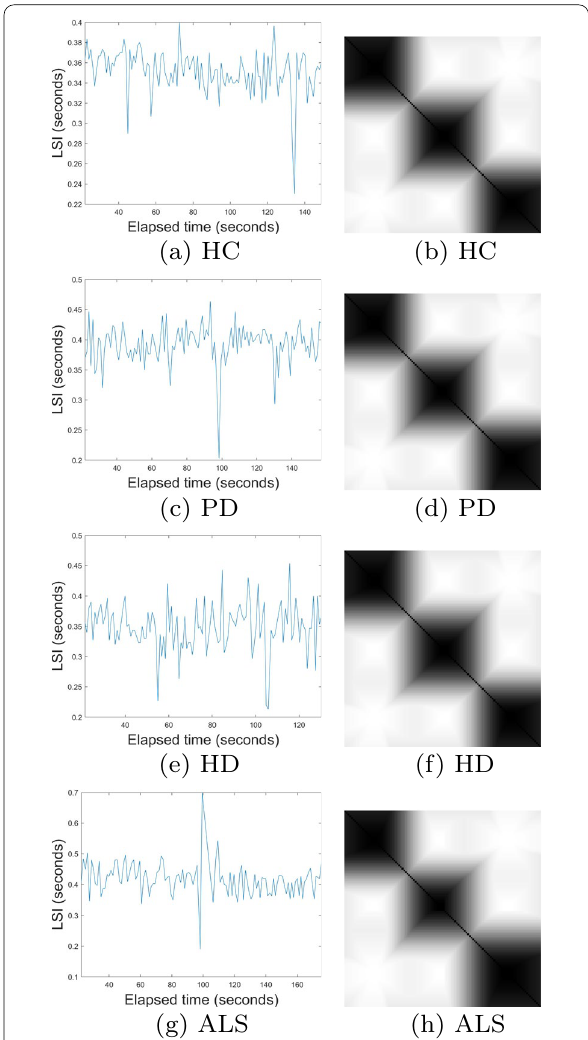
Fig. 4 Time series of right swing intervals (left) and fuzzy recurrence plots (right) of healthy control and neurodegenerative